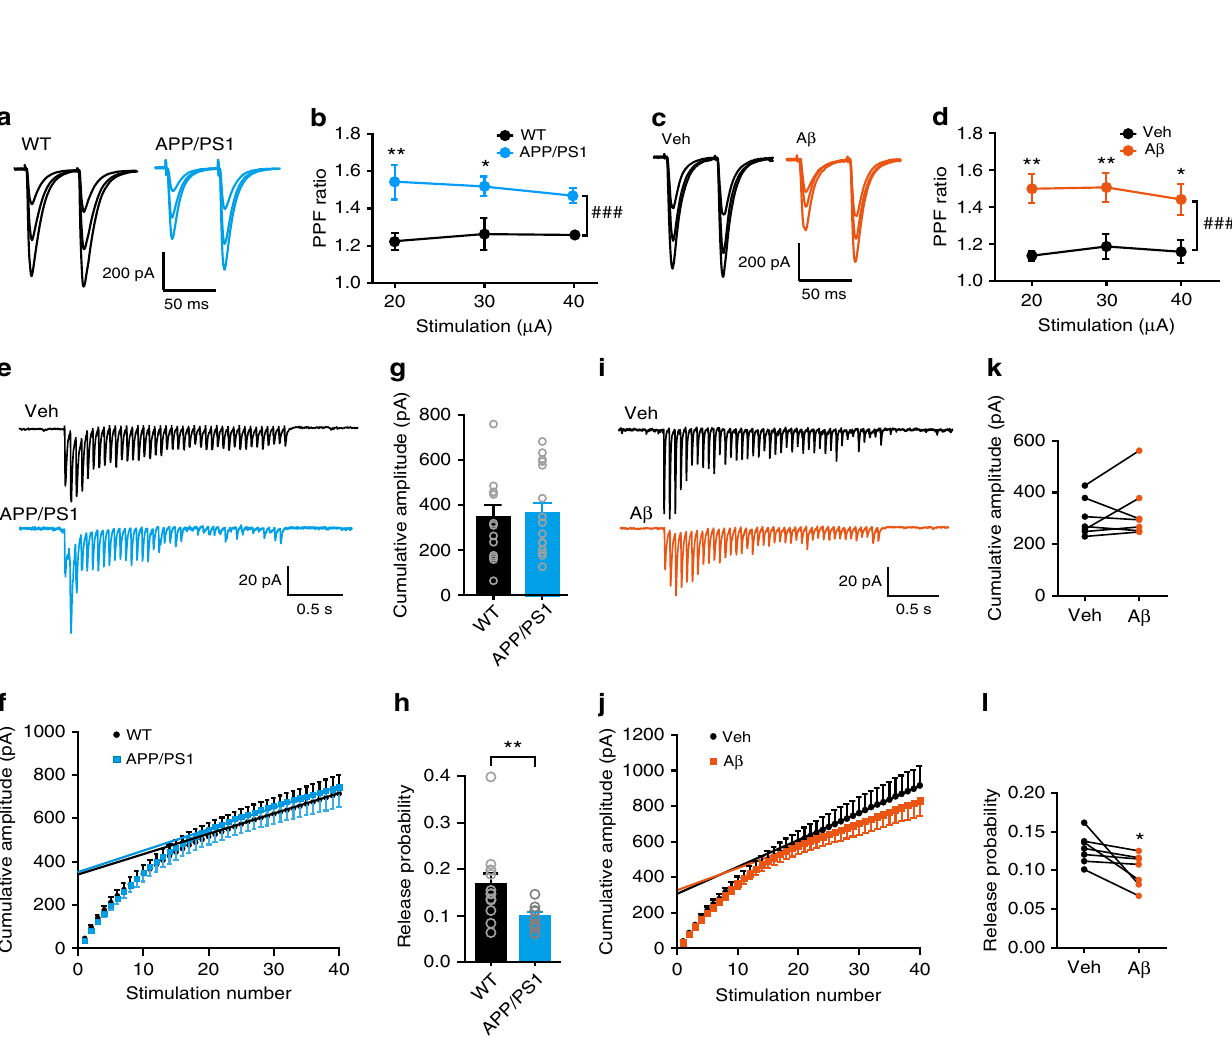
Fig. 2 High nanomolar A β oligomers suppress presynaptic release probability at the SC-CA1 synapse. a – d Representative traces ( a , c ) and quanti fi cation ( b , d ) of PPF of SC-CA1 EPSCs evoked by stimulus intensities of 20, 30, and 40 μ A in 6 – 7-month-old WT and APP/PS1 mice ( a , b ) and in oligomeric A β (400 nM)-treated hippocampal slices relative to vehicle (Veh)-treated ones ( c , d ). Two-way ANOVA with post hoc Bonferroni test; in b : animal, F = 32.67, P < 0.001; stimulation, F = 0.2378, P = 0.89; in d : treatment, F = 34.63, P < 0.001; stimulation, F = 0.029, P = 0.79; (1,24) (2,24) (1,24) (2,24) ### P < 0.001; * P < 0.05; ** P < 0.01; N = 5 per group. e Representative traces showing the response of CA1 pyramidal neurons to 20 Hz stimulation of the SC in 6 – 7-month-old WT and APP/PS1 mice. f – h Cumulative amplitude analysis showing the magnitude of the cumulative amplitude ( f ), RRP size ( f , g ), de fi ned as the y-intercept of the linear portion of the curve, and the release probability ( h ), calculated as mean EPSC amplitude (the mean value of the 1st EPSCs) divided by RRP size, in WT and APP/PS1 mice. t test; ** P < 0.05; N = 13 – 15 per group. i Representative traces showing the response of the SC-CA1 synapse to 20 Hz stimulation before (Veh) and after bath application of 400 nM A β oligomers in WT hippocampal slices. j – l Cumulative amplitude analysis ( j ) showing the effect of 400 nM A β oligomers on RRP size ( j , k ) and the release probability ( l ) at the SC-CA1 synapse. t test; * P < 0.05; N = 7 per group. Data are mean ± SEM. Source data are provided as a Source Data fi